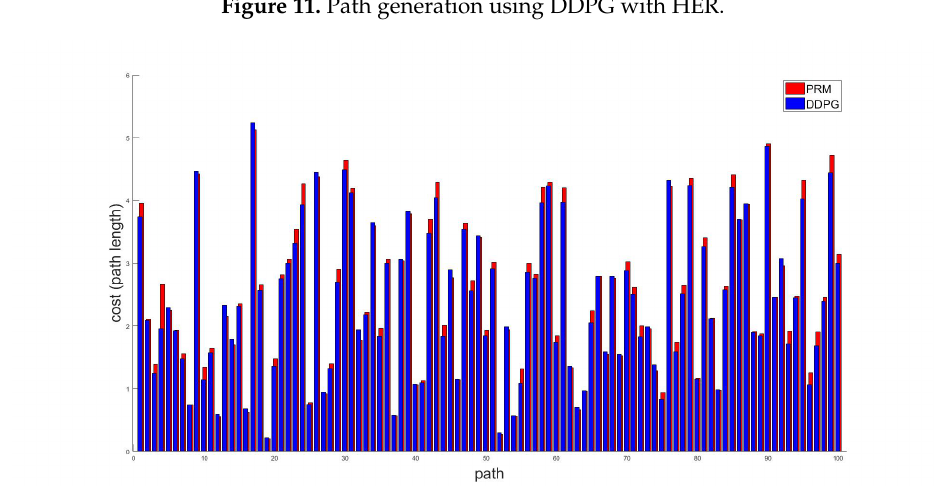
Figure 12. Comparison of paths by PRM and the proposed